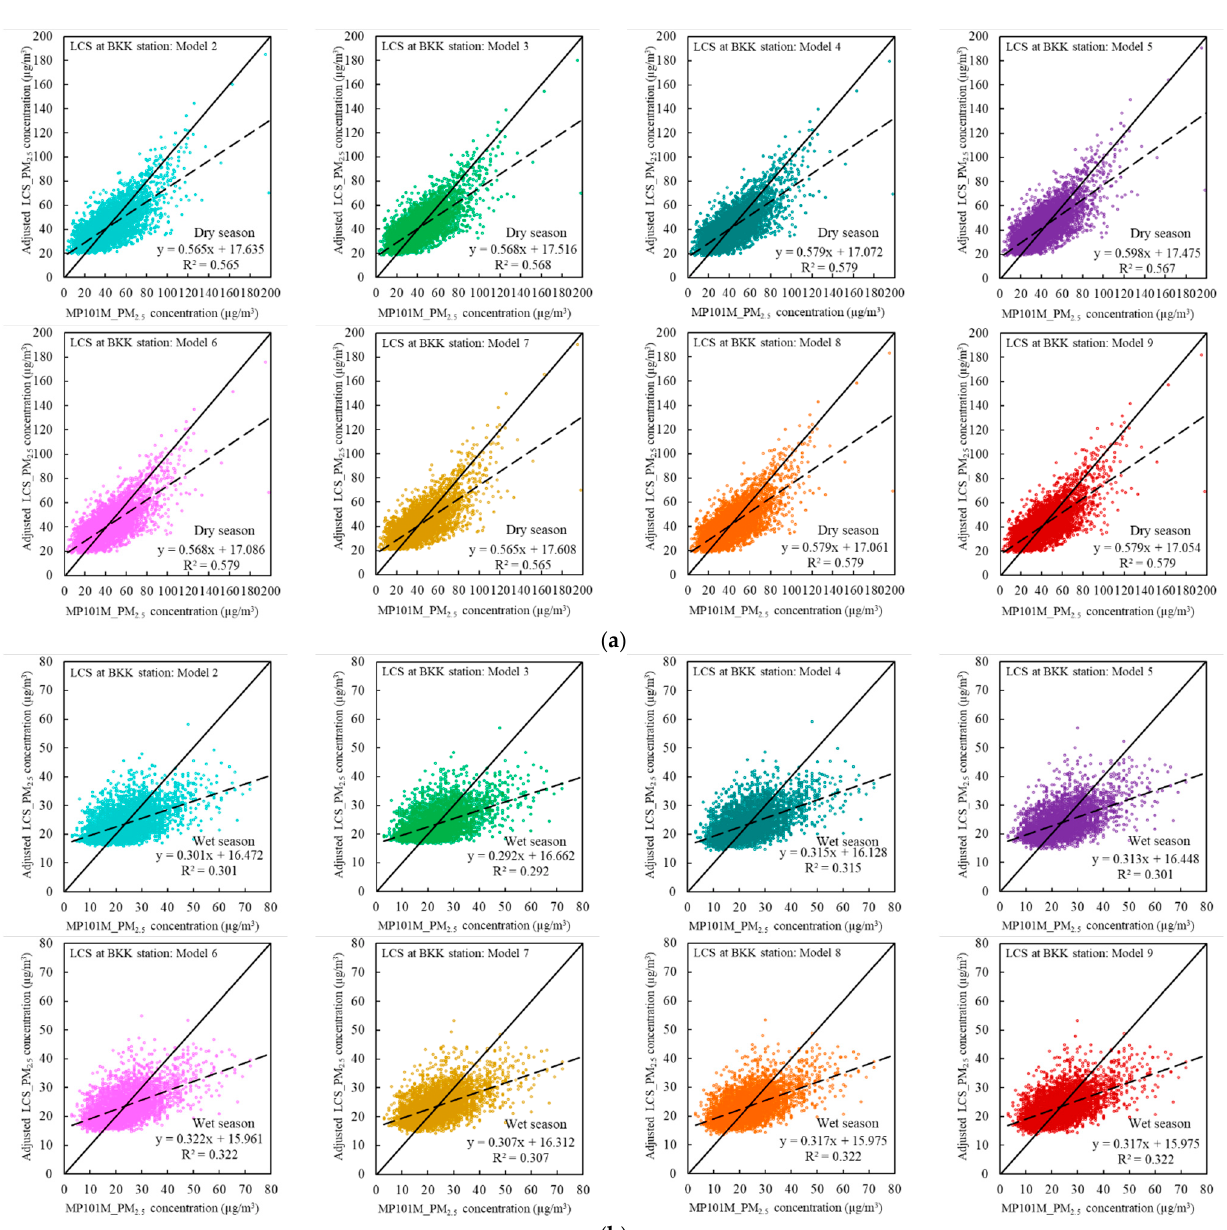
Figure A2. Correlation of 1-h PM 2.5 concentration between adjusted LCS by MRL models vs. FEM during the ( a ) dry and ( b ) wet seasons at BKK. The solid line is the line with slope =1 while the dashed line represents the fitting.